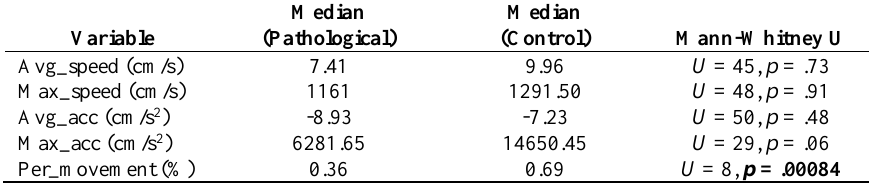
Observed Values for Analyzed Variables and Differences Between Groups Variable